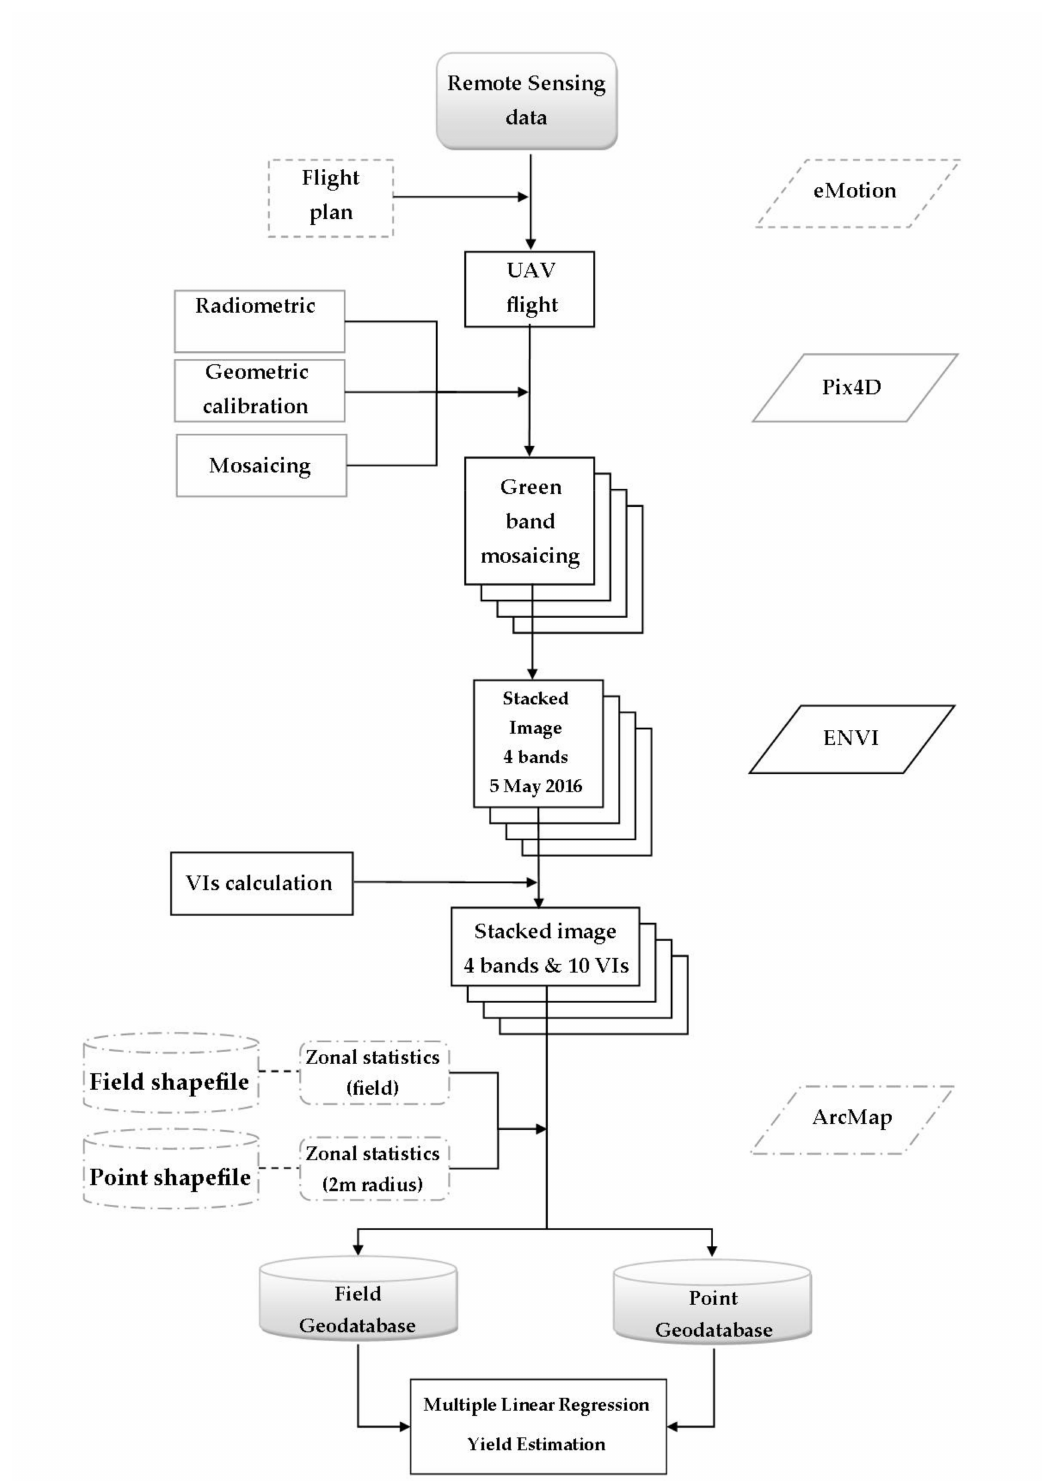
Figure 6. Flowchart of data